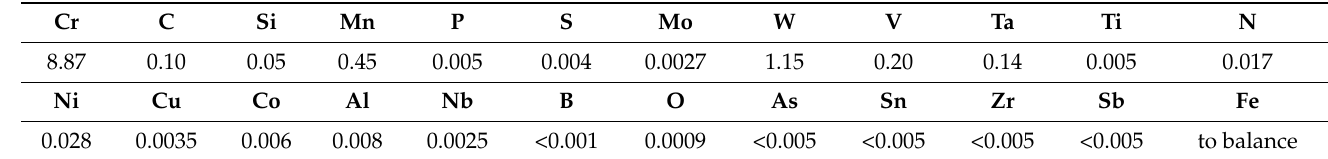
Table 2. Nominal chemical composition of Eurofer-97 steel (wt%).